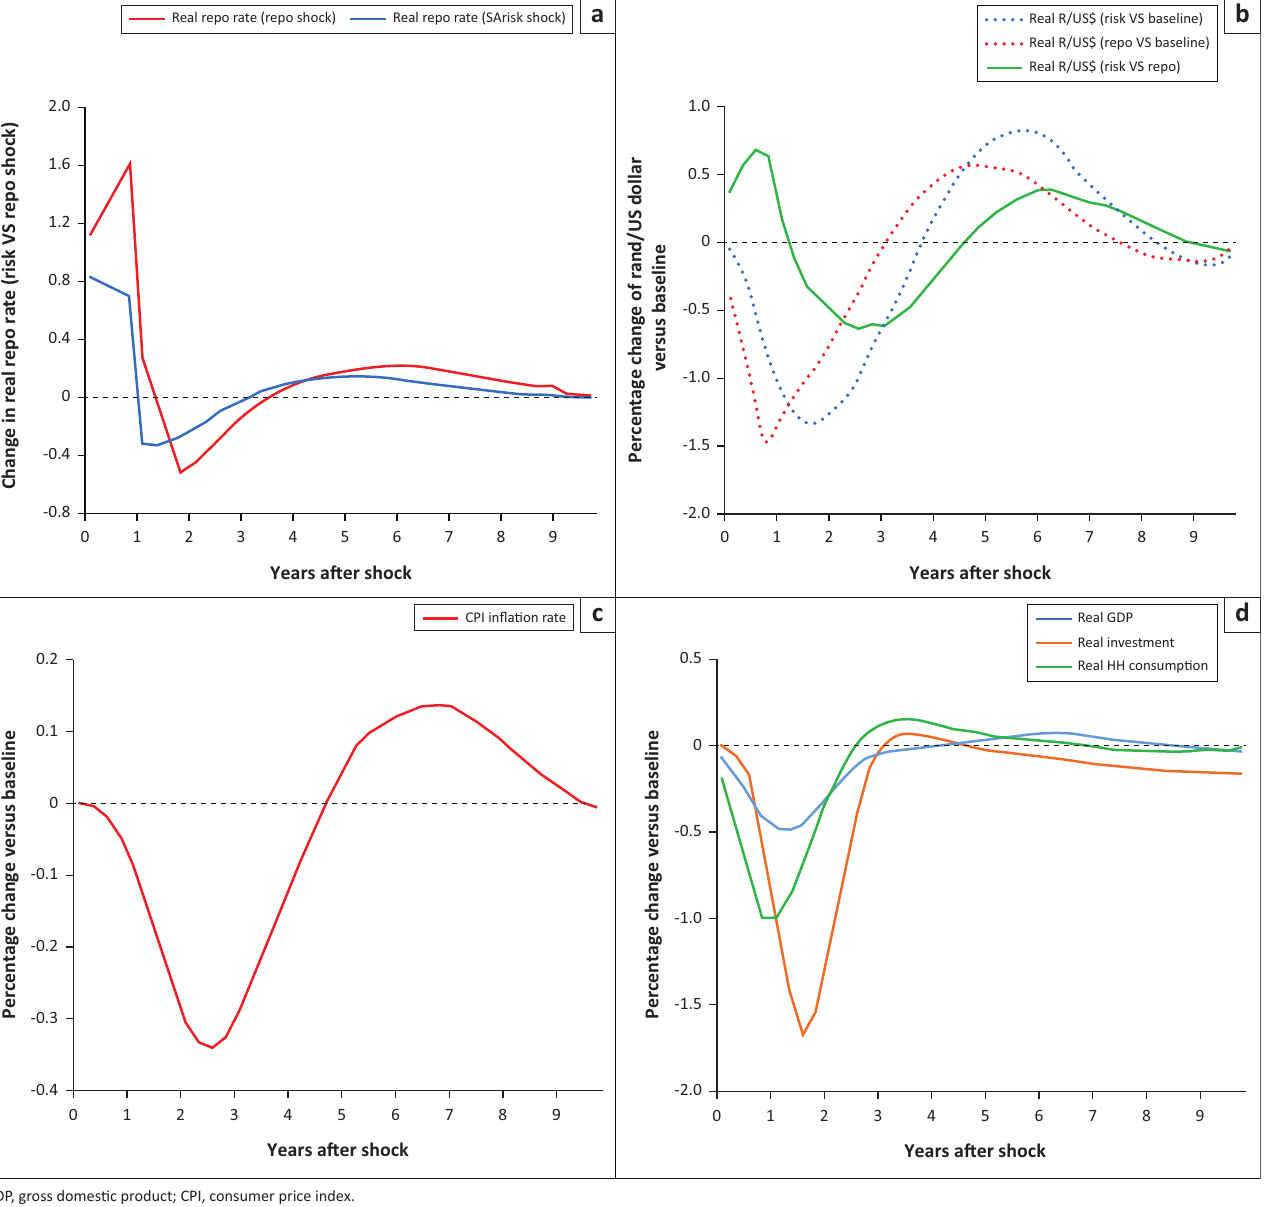
FIGURE 6: Model response to four-quarter (a-d) real South African risk shock. TABLE 1: Shocks to the model. Period Scenario